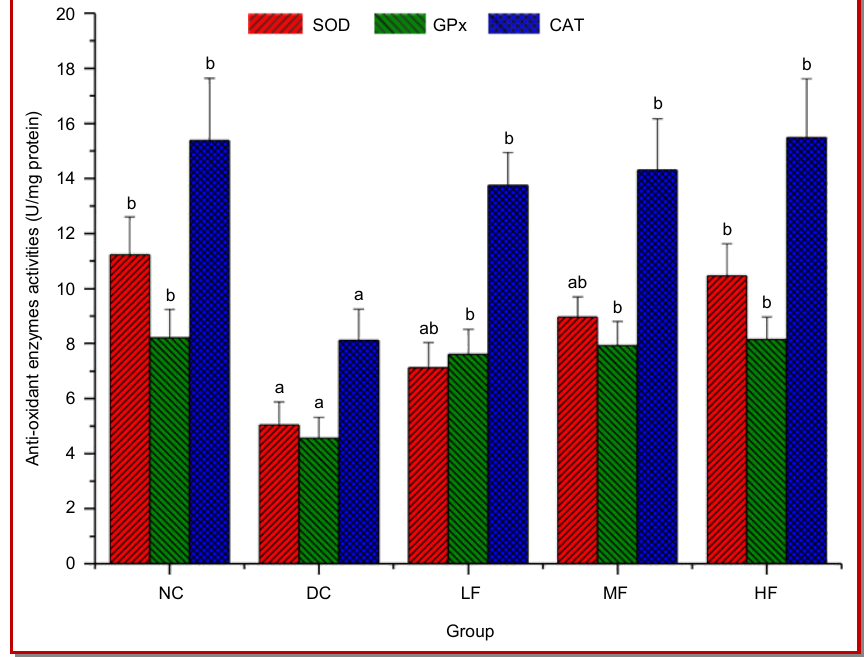
Figure 3: Effects of FTB on anti-oxidant enzymes activities in kidney in mice; NC means normal control; DC means diabetic con- trol; Diabetic mice received low dose (LF) , middle dose (MF) and high dose (HF) of